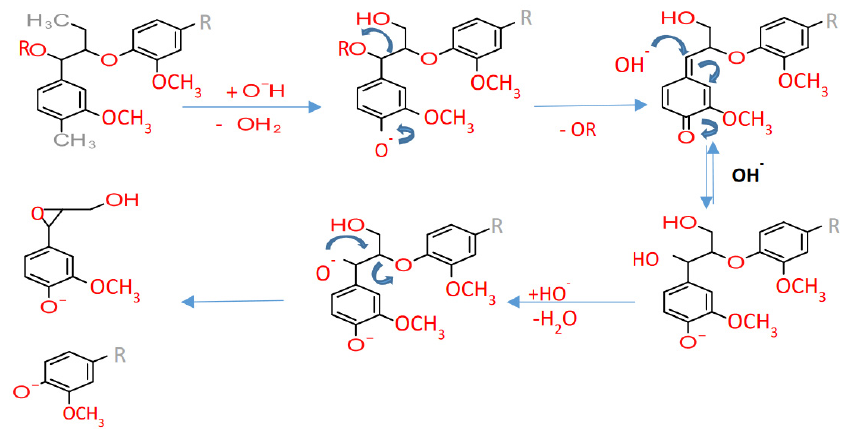
Figure 9. Cleavage of the α and β ether linkage during the soda/alkaline process.